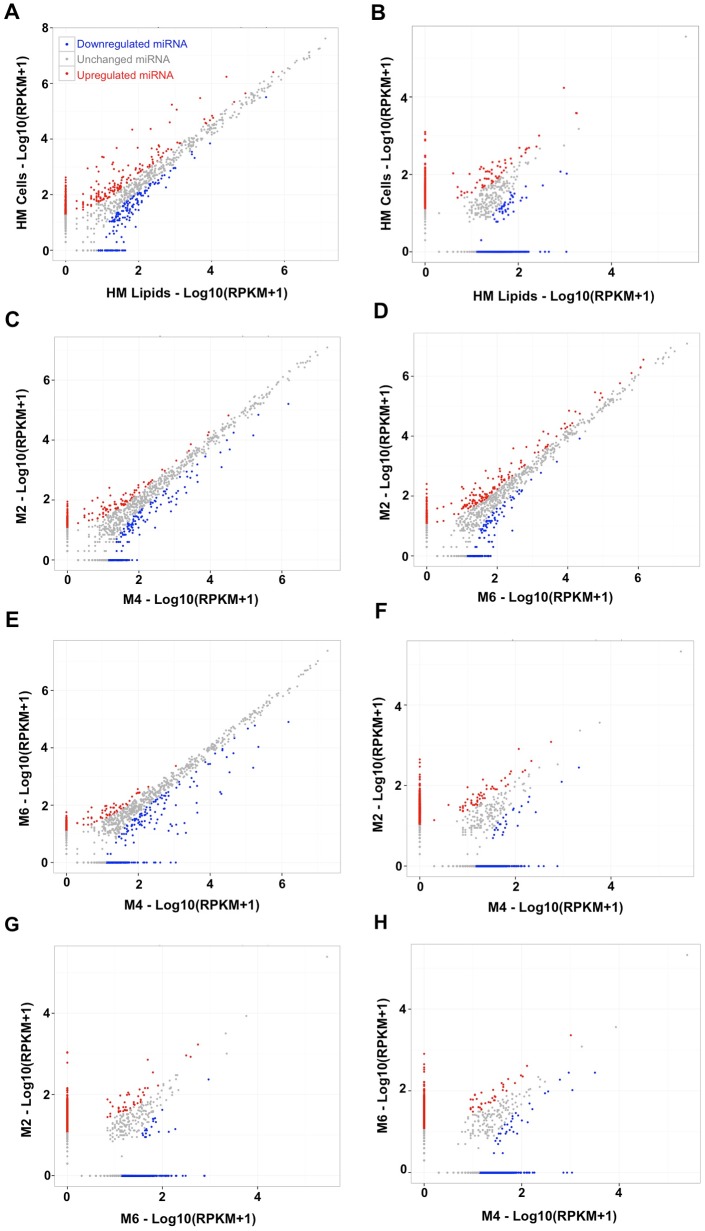
(A, B) Scatter plots showing the differentially expressed (A) known and (B) novel miRNAs in cell and lipid HM samples. (C, D, E) Differentially expressed known miRNAs between months M2 and M4 (C), M2 and M6 (D), and M4 and M6 (E). (F, G, H) Differentially expressed novel miRNAs between months M2 and M4 (F), M2 and M6 (G), and M4 and M6 (H). Each dot represents an individual miRNA, where red and blue refer to up- and down-regulated miRNAs respectively, and grey dots refer to no change of expression of a given miRNA.